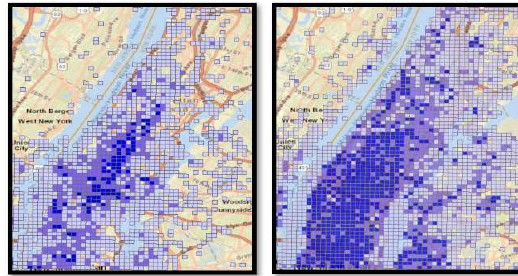
Figure 4. Tourism descriptors calculated for the photos downloaded from Flickr for the area of Manhattan, New-York : (a) Number of photographers vs. traveled number of days; (b) Accumulated traveled average distance vs. traveled number of days; (c) Average photo volume per photographer vs. traveled number of days; (d) Average speed vs. traveled number of days.